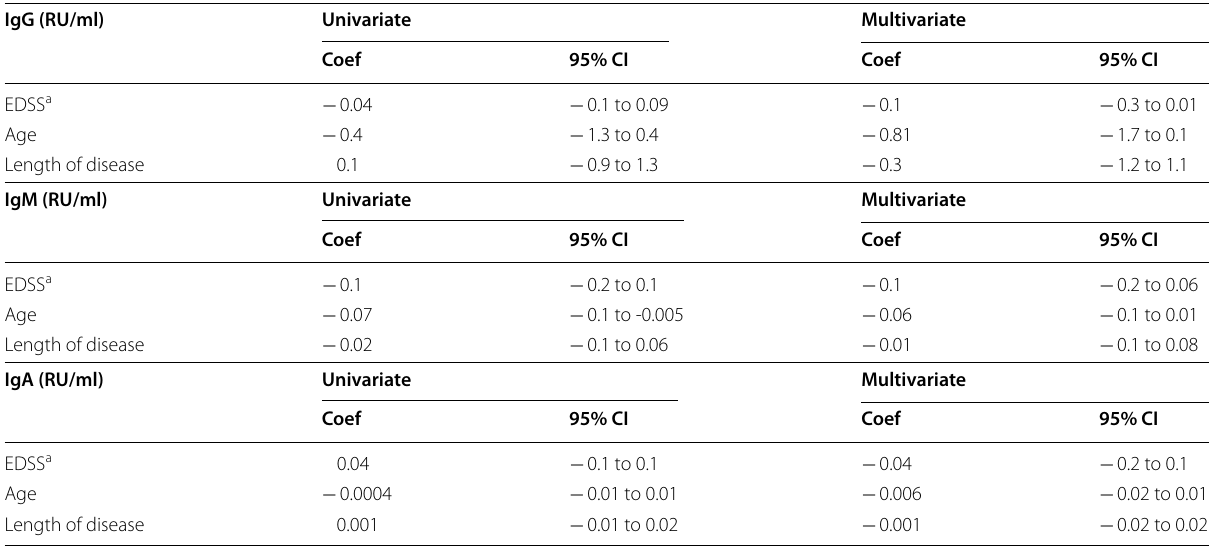
Phenotype of multiple sclerosis, sex, and previous history of immunomodulatory agents were used as covariates for the multivariate analysis RU/ml Relative units per milliliter; EDSS Expanded disability status scale; Coef Regression coefficient; 95% CI 95% confidence interval a EDSS was considered as an ordinal variable and ordinal linear regression was conducted for this